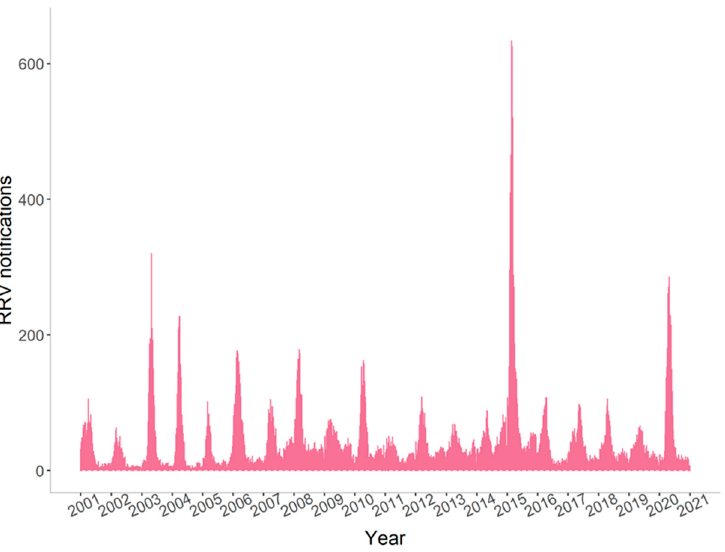
Figure 1. Weekly Ross River virus notifications in Queensland, 2001–2020.